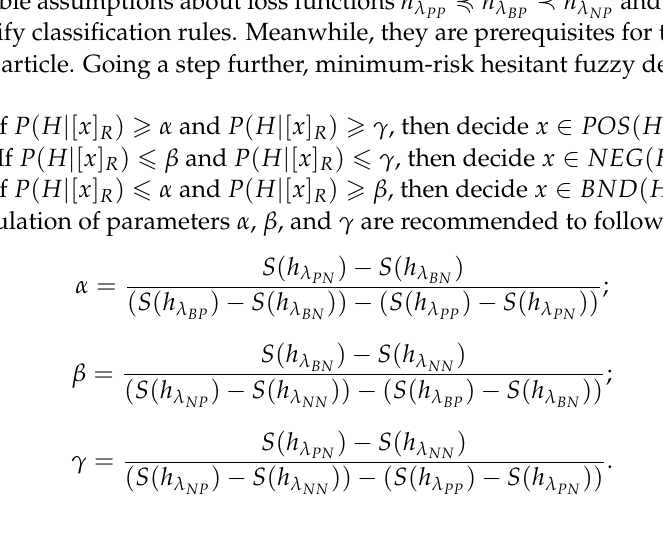
Table 1. The hesitant fuzzy loss function. a